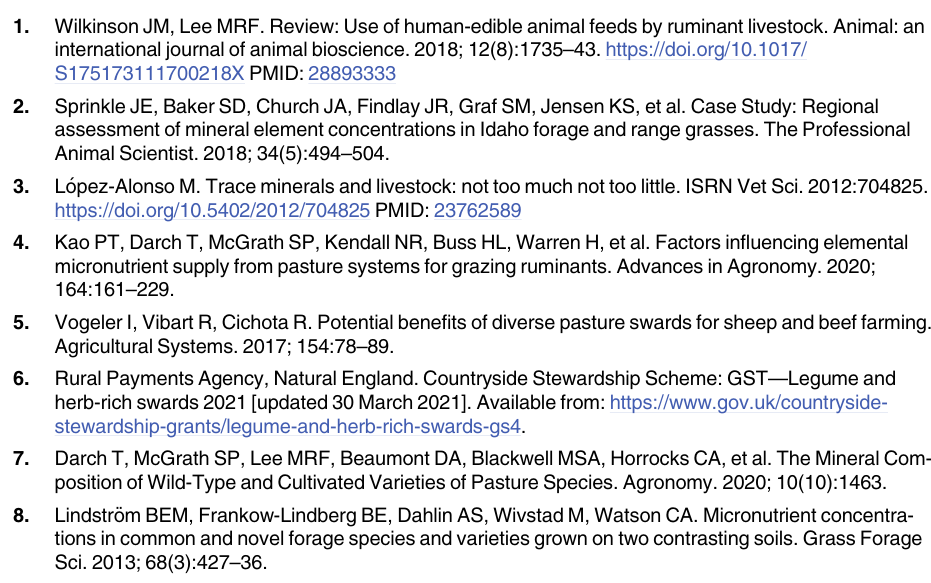
Error bars indicate the confidence interval of the back-transformed mean.